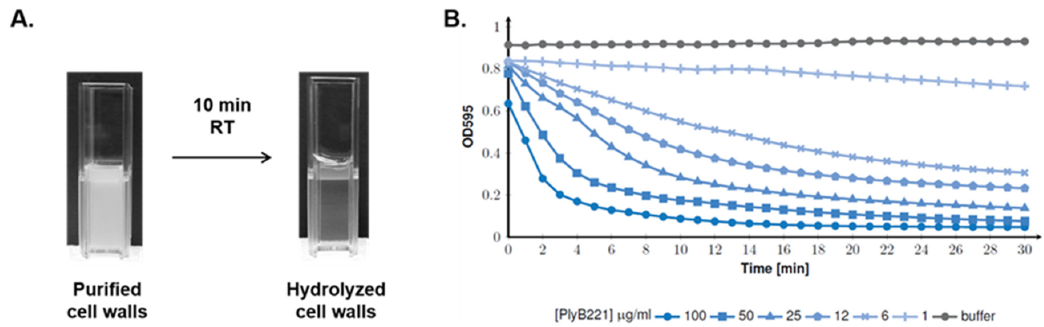
Figure 6. PlyB221 activity on purified cell wall extracts. Cell wall extracts from B. cereus ATCC 10,987 were purified and mixed by PlyB221. ( A ) Macroscopic observation of B. cereus cell wall hydrolysis with 100 µg of endolysin after 10 min at RT. ( B ) OD 595 monitoring during 30 min (30 °C) of cell wall hydrolysis using endolysin concentrations ranging from 1 to 100 µg/mL.